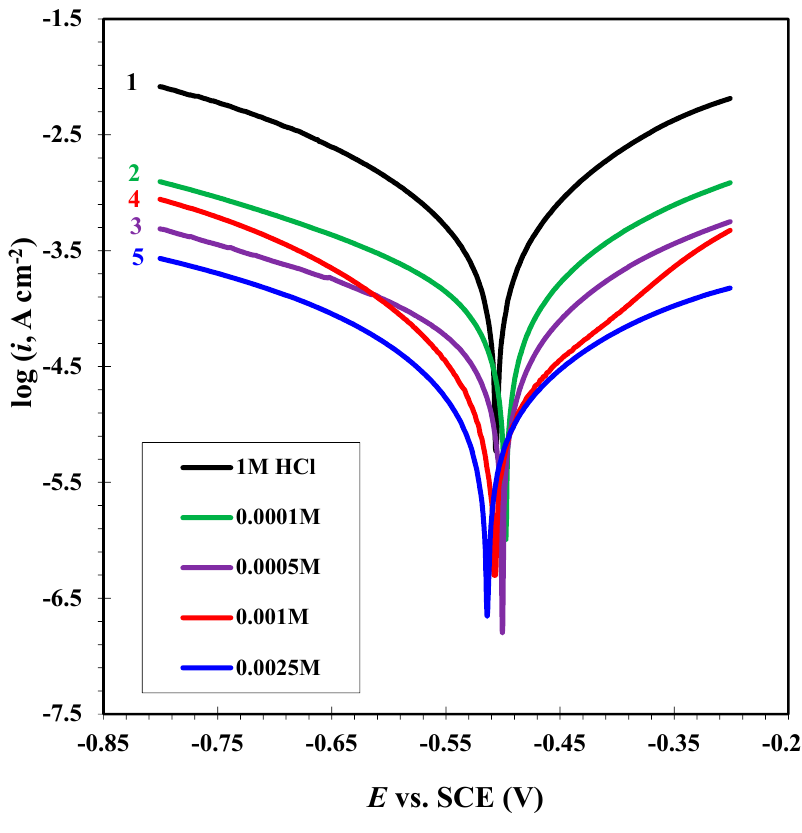
Figure 4. Anodic and cathodic polarization curves for MS obtained at 20 ◦ C in 1 M HCl solution in the absence and presence of di ff erent concentrations of CGSES12.